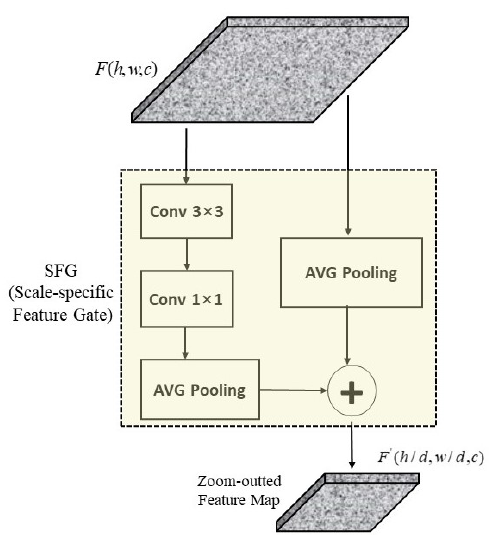
Figure 3. The structure of a